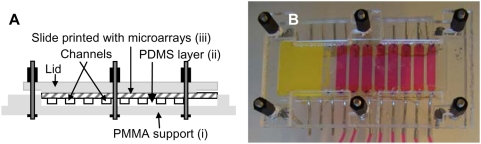
The multi-stringency array washer (MSAW).(A) Schematic drawing of an assembled system viewed from the side. The main parts of the device are shown: (i) the PMMA support; (ii) the PDMS layer, which defines the fluidic channels and the alignment groove for the microscope slide; (iii) the microscope slide printed with identical subarrays that face towards corresponding chambers after the device is sealed. (B) Photograph of the assembled MSAW.